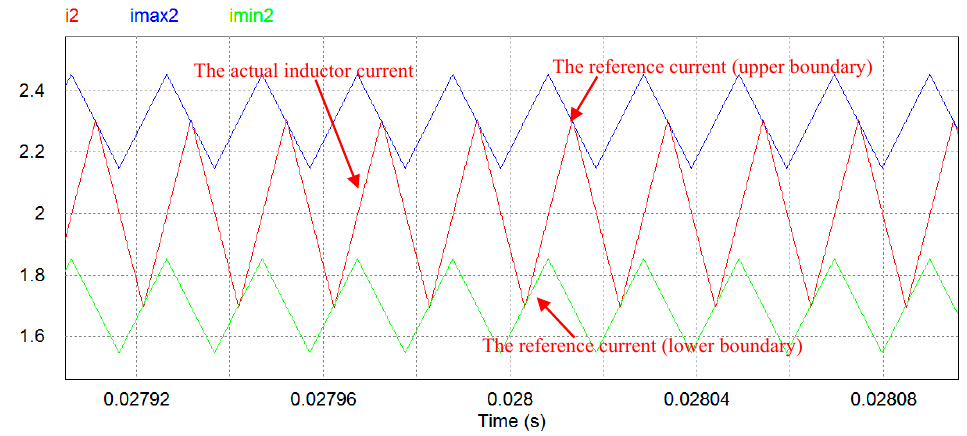
Figure 16. The inductor current with the reference current boundaries.